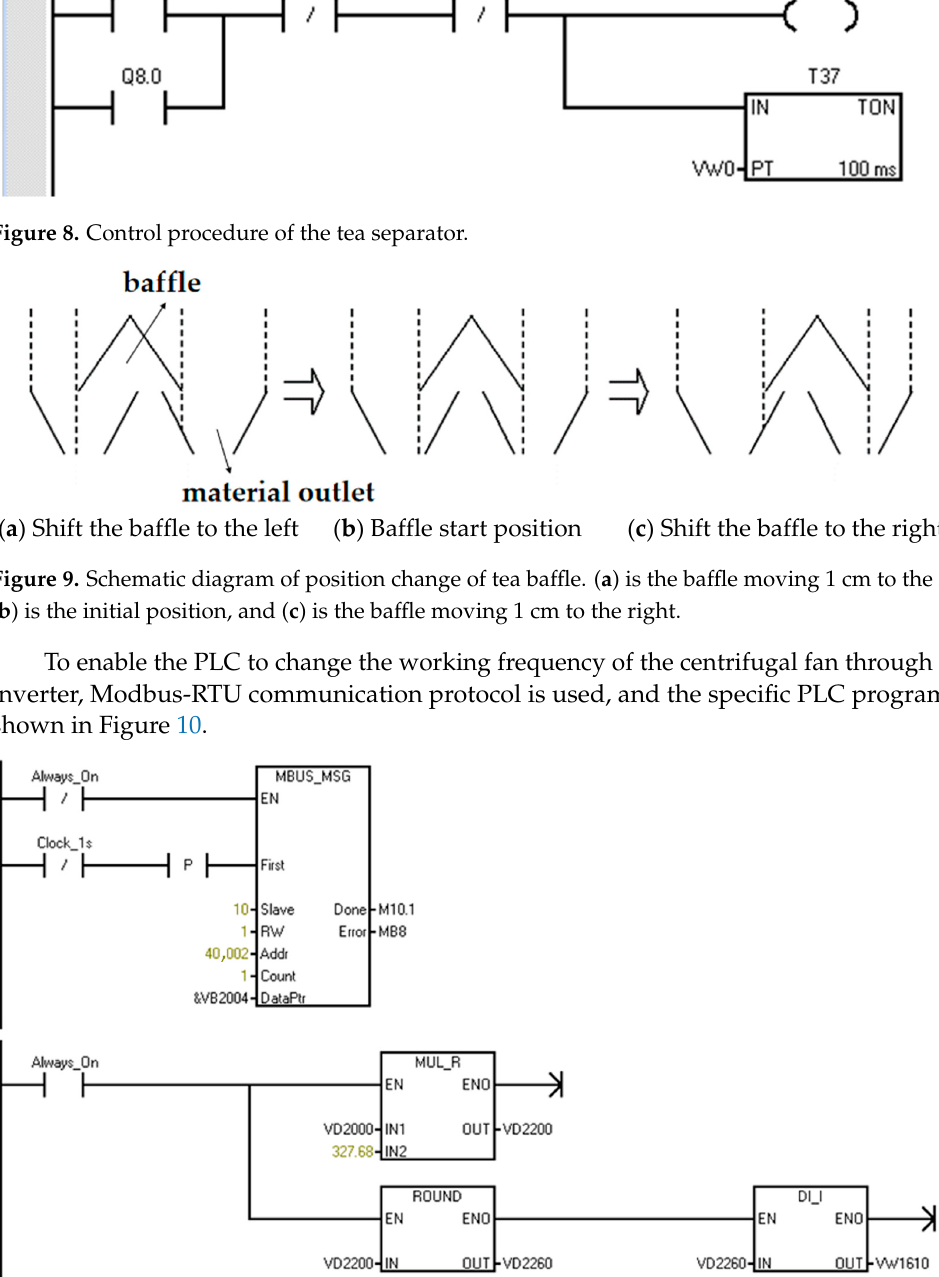
Figure 11. Configuration interface.